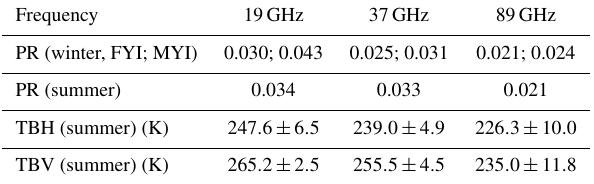
Table 11. Top row: winter tie points for first-year ice (FYI) and mul- tiyear ice (MYI) expressed as normalized brightness-temperature polarization difference (PR); other rows: summer tie points derived as outlined in the text expressed as PR and brightness temperature (TB) at vertical (TBV) and horizontal (TBH) polarization. Bright- ness temperatures are given together with 1 standard deviation. Frequency 19GHz 37GHz 89GHz PR (winter, FYI; MYI) 0.030; 0.043 0.025;